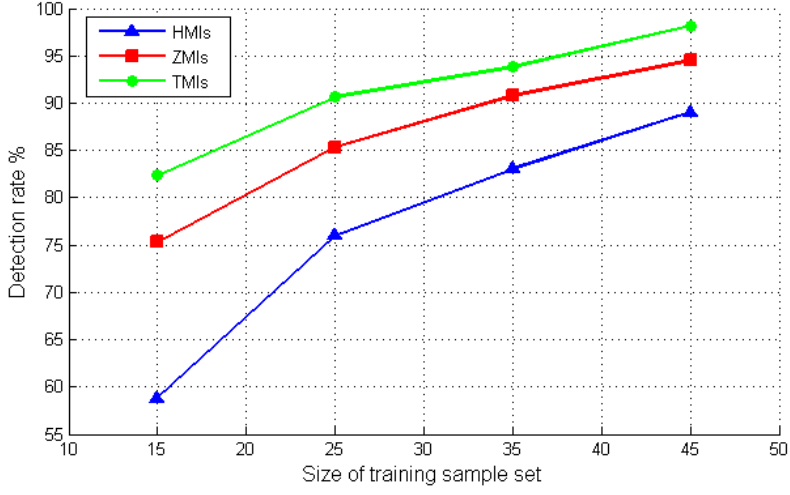
Figure 6. Effect of training dataset size on recognition rate.